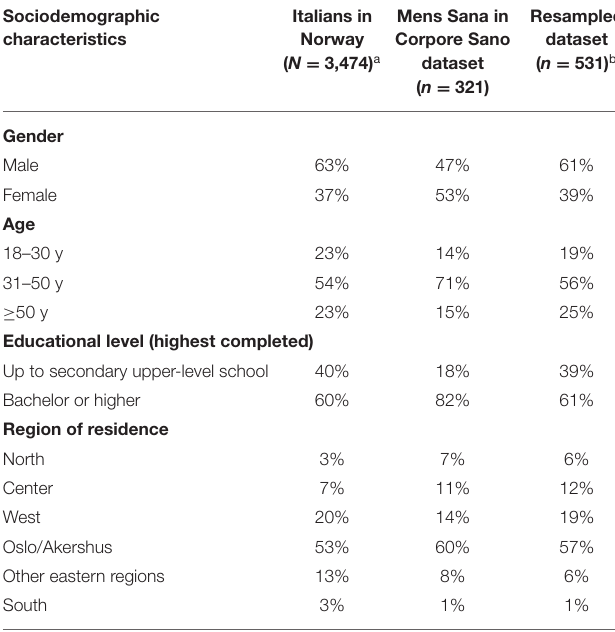
TABLE 1 | Data distribution of the reference population, the original dataset, and the resampled dataset. Sociodemographic